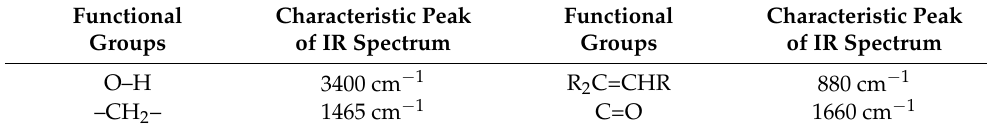
Table 1. Infrared characteristic absorption peaks of different functional groups.